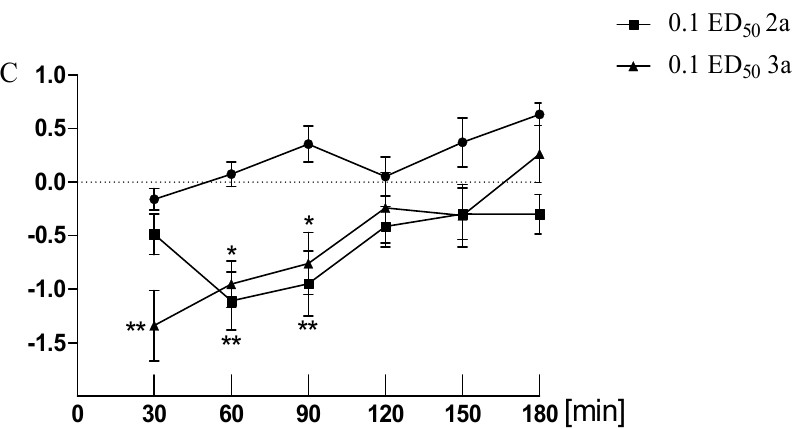
Figure 3. The influence of 1a , 2a and 3a on the spontaneous locomotor activity of mice. One-way ANOVA showed significant changes in locomotor activity of mice [F p < 0.0001]. The post hoc Dunnett’s test confirmed a significant reduction in motility of mice after the administration of the compound 1a in the dose of 0.1 ED compounds 2a , 3a in the dose of 0.1 ED